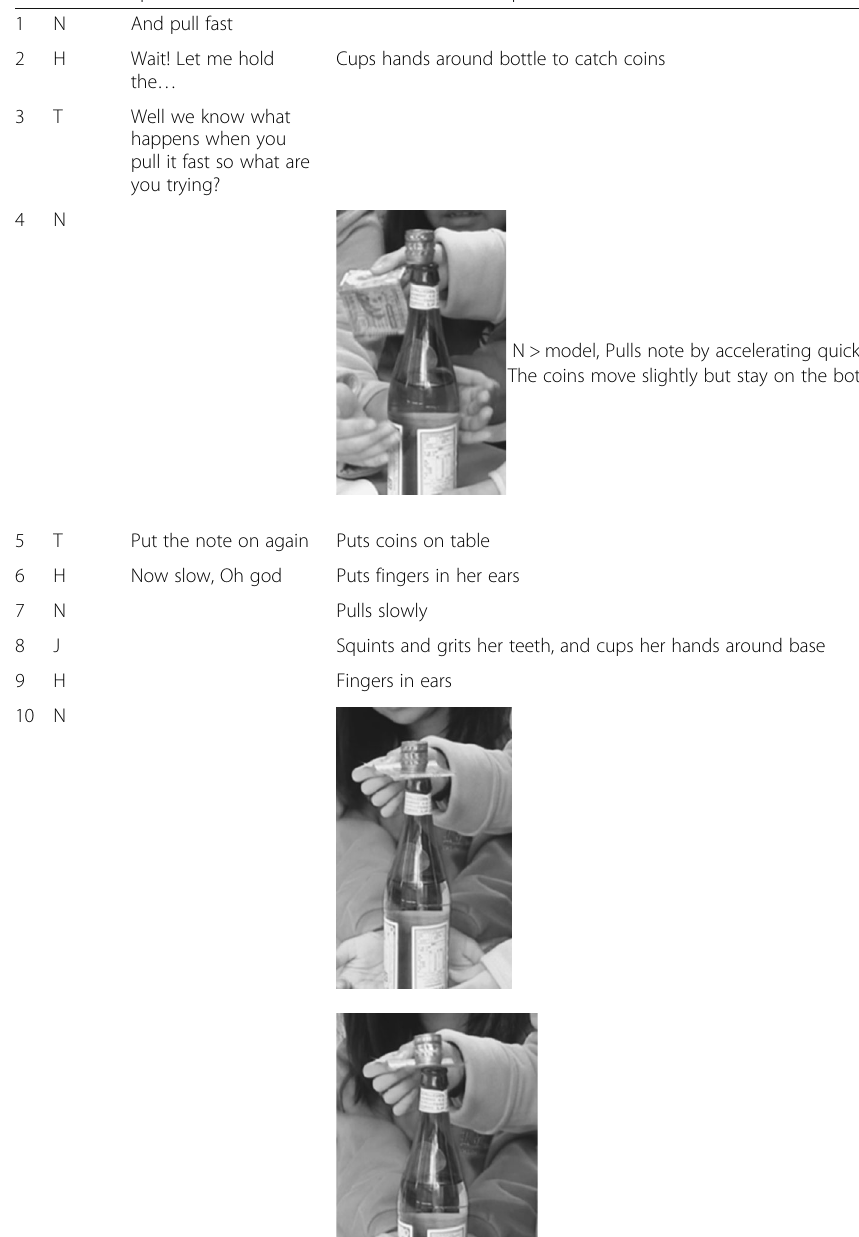
Table 2 Using Alternative Modes to Test an Idea in Group